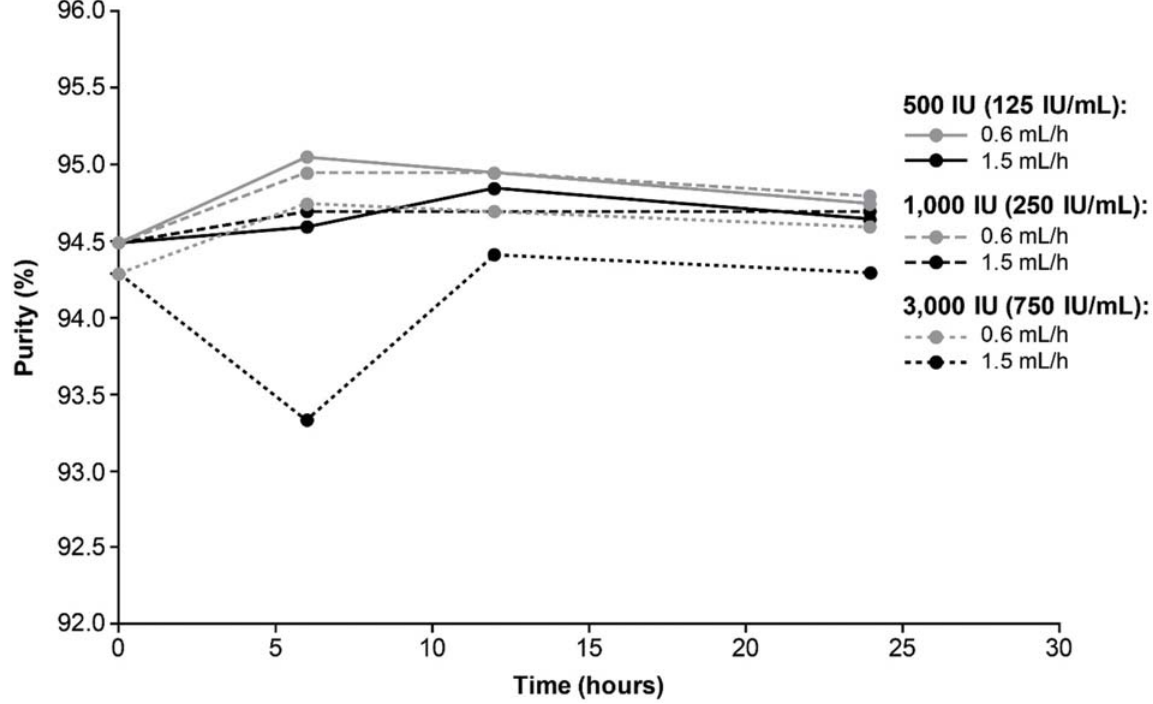
Fig. 2 Purity of turoctocog alfa assessed during 24 hours of CI at pump speeds of 0.6 and 1.5 mL/h. The following turoctocog alfa samples were assessed: 500 IU (equating to 125 IU/mL), 1,000 IU (equating to 250 IU/mL), and 3,000 IU (equating to 750 IU/mL). CI, continuous Purity strengths of turoctocog alfa and both pump speeds evaluat- The purity of turoctocog alfa at t ¼ 0 hours was 94.4 and prede fi ned acceptance limits.